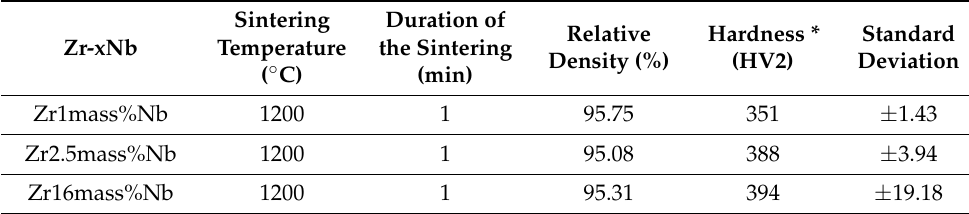
Table 3. The SPS process parameters, relatively densities, hardness of the sintered Zr-xNb materials obtained from mixtures with the 1–5 µ m niobium powder, milled in water.